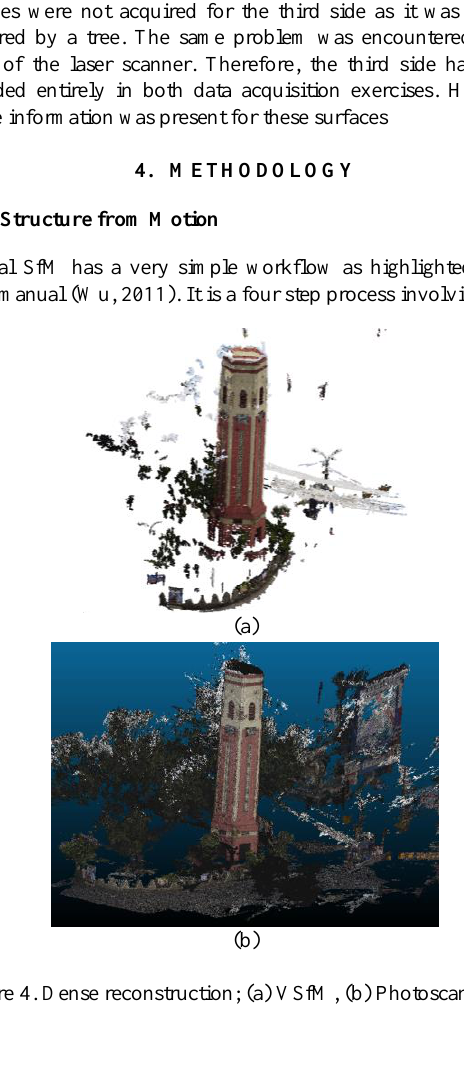
Figure 3: Sparse point cloud with camera positions